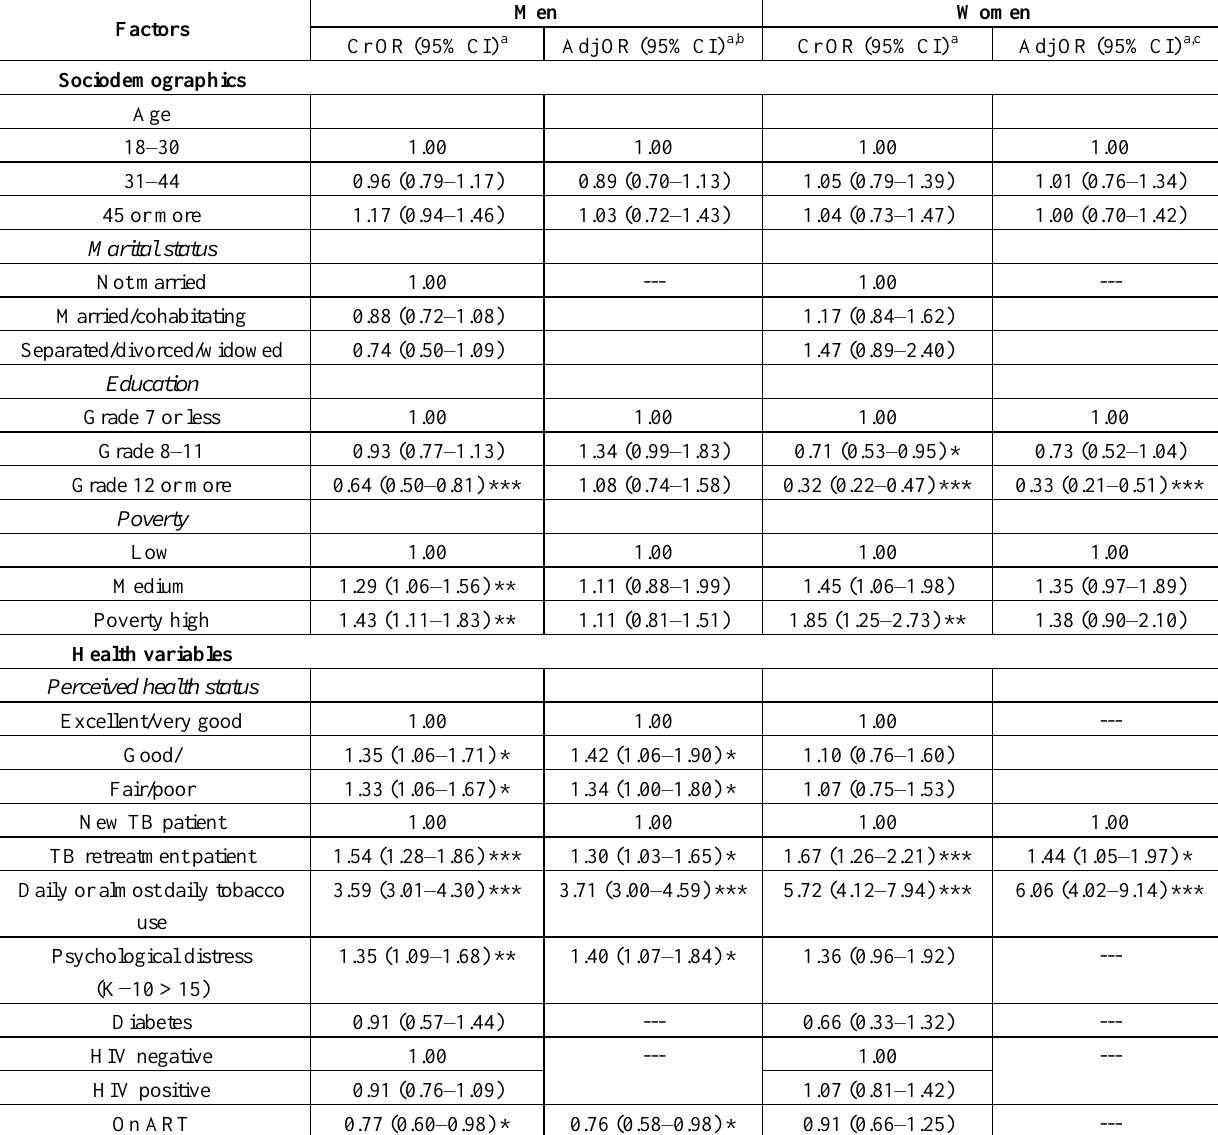
Table 3. Results of logistic regression: Associations between sociodemograhic and health variables and hazardous or harmful alcohol